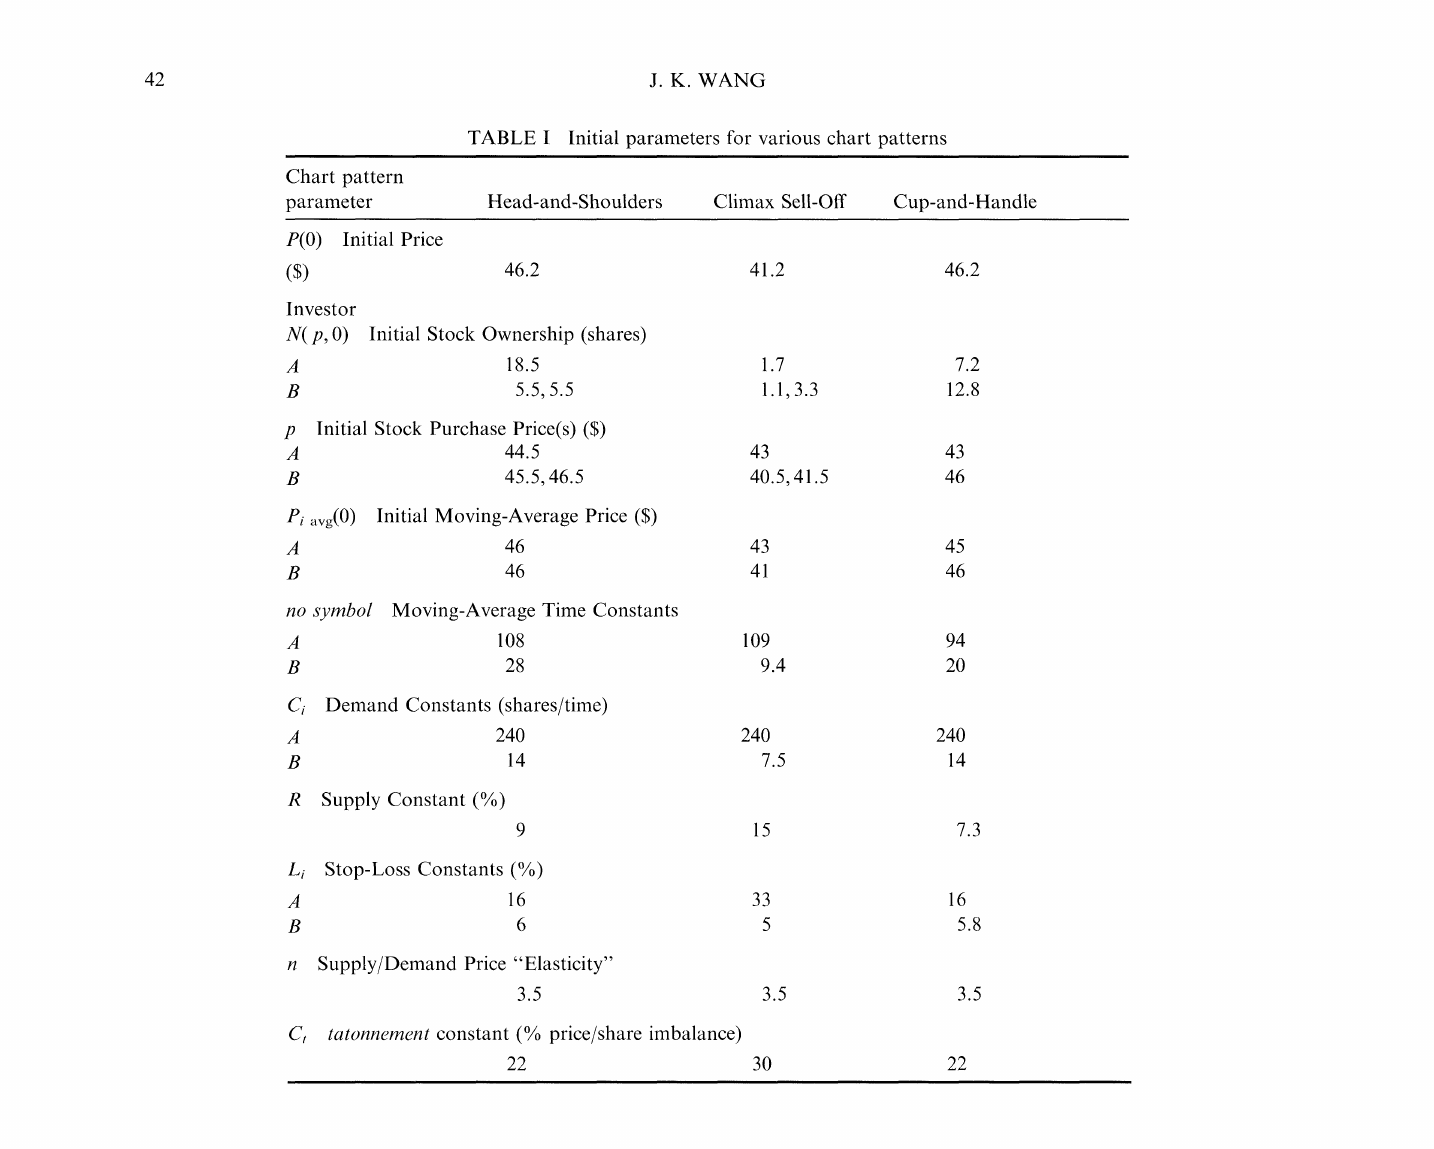
Initial parameters for various chart